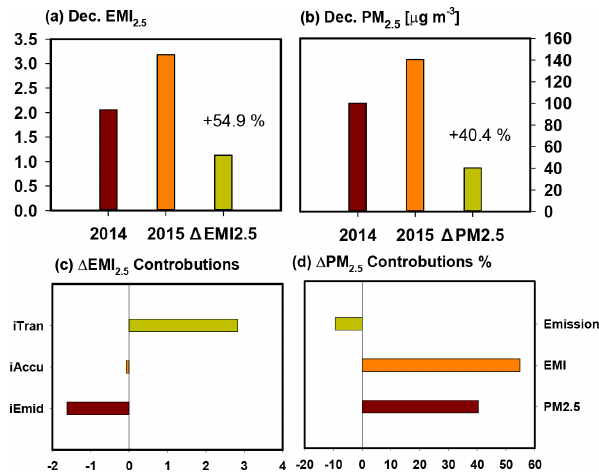
Figure 5. (a) The monthly averaged EMI 2 . 5 and (b) monthly PM 2 . 5 for the Decembers of 2014 and 2015 over BTH. (c) Contributions of the sub-index to the EMI 2 . 5 change and (d) contributions of emis- sion and meteorology changes to PM 2 . 5 change for the Decembers from 2014 to 2015,